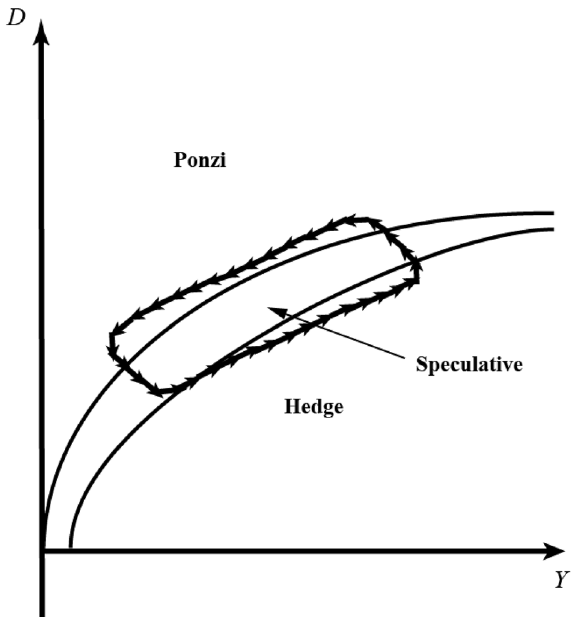
Fig. 7 Financial regimes and cycle: system S